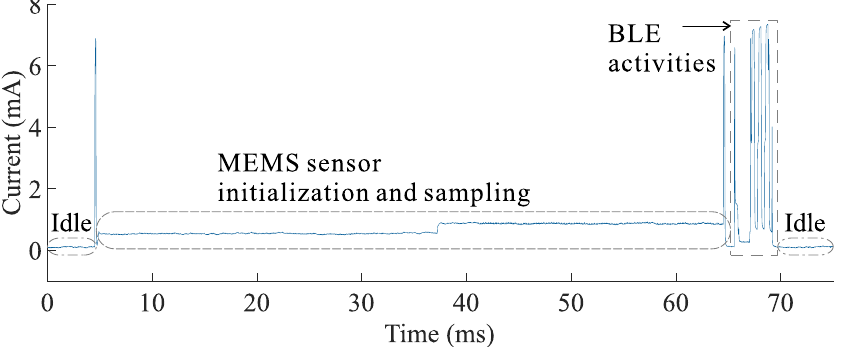
Figure 7. The current profile for the wireless sensor working in operating mode 1. The sensor is operated with a constant supply voltage of